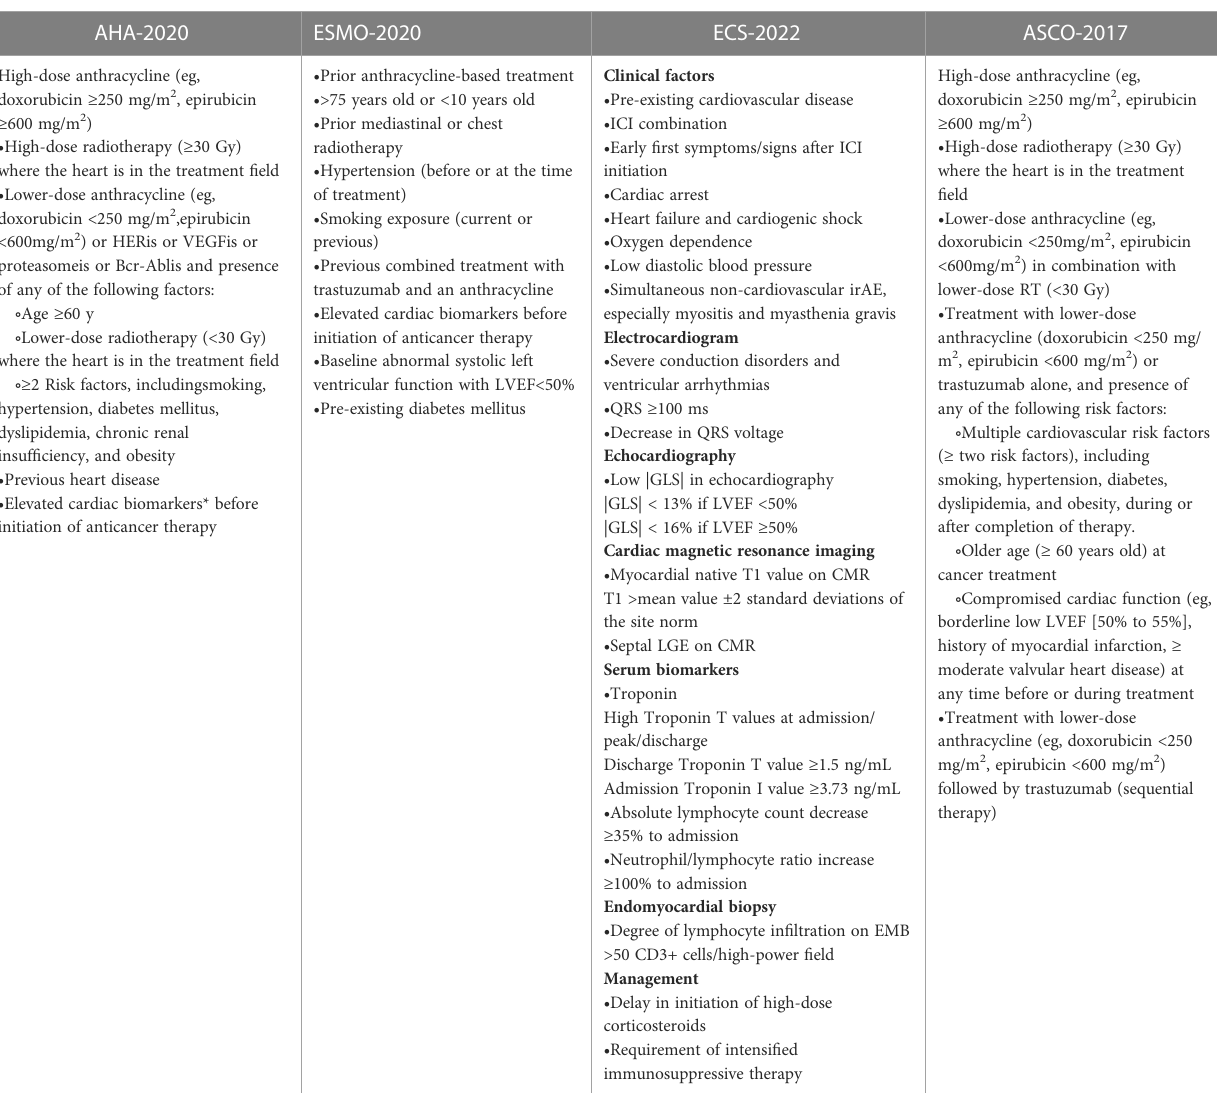
TABLE 1 Risk factors for the treatment of immune checkpoint